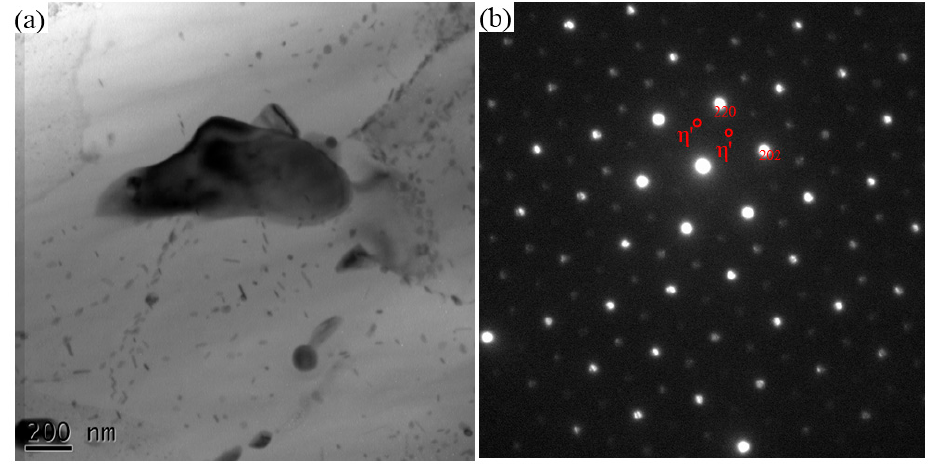
Figure 6. TEM of ( a ) Precipitates in the nugget and ( b ) selected area electron diffraction (SAED) pattern.